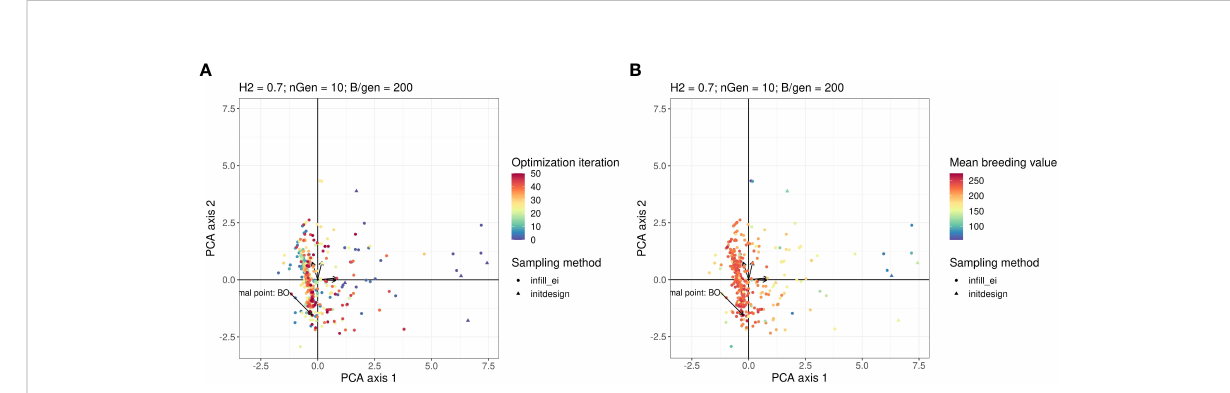
FIGURE 3 Points in the parameter space explored by the Bayesian optimisation projected on the PCA plan. This plan was calculated using the points explored by the Bayesian optimisation as active individuals. The arrows starting from the origin of the graph are the projections of the active variables. For readability, the variable names associated with each arrow are not written, but this can be found in the Figure in the Supplementary Material. Points in the sub- fi gure (A) are coloured according to their iteration and those in the sub- fi gure (B) are coloured according to their corresponding value returned by the objective function.